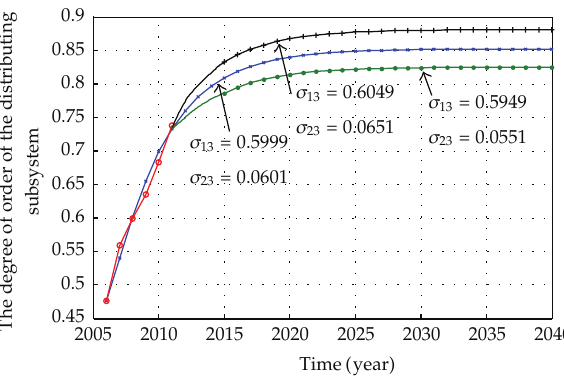
Figure 8: The ordered synergistic coevolution of the distributing subsystem with di ff erent synergistic coe ffi cients.